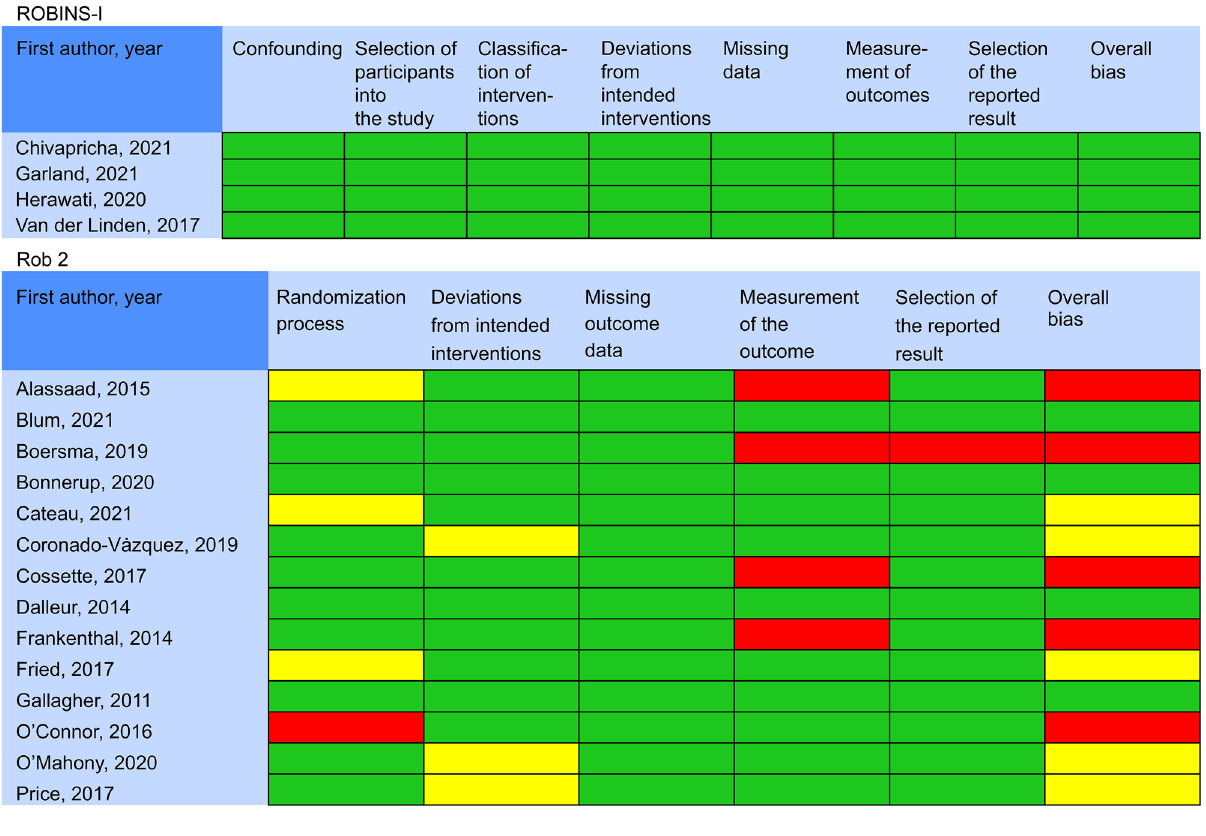
Figure 2. Risk of bias